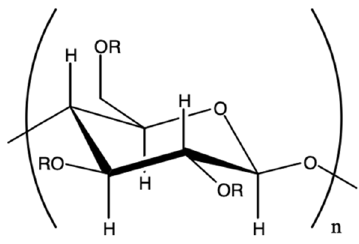
Figure 2. The chemical structure of methylcellulose.